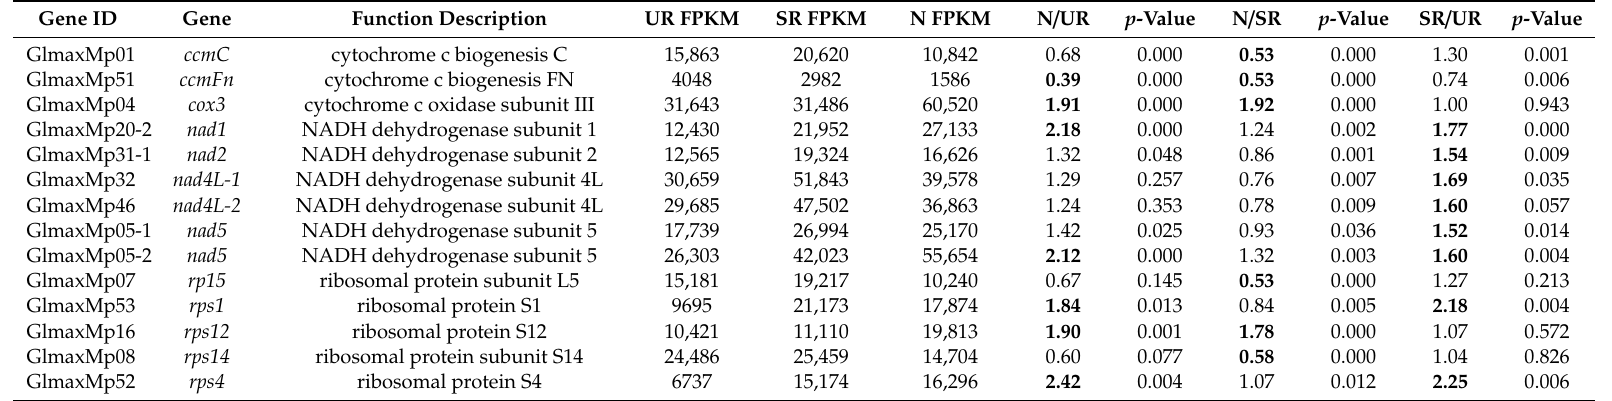
Table 2. Di ff erentially expressed mitochondrial